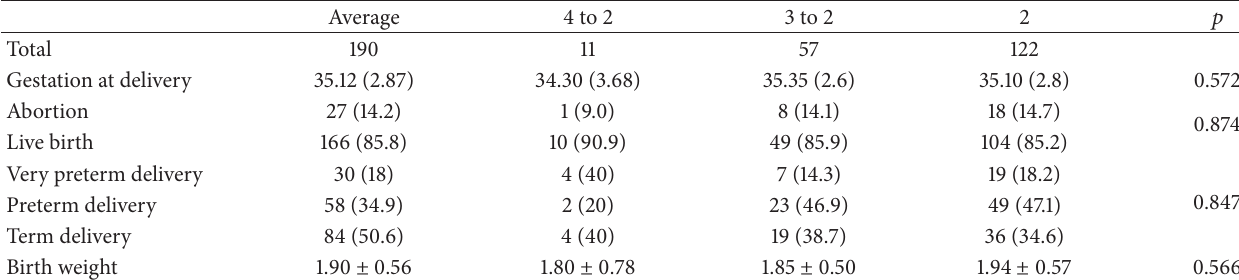
Table 3: Outcome in twin gestation.